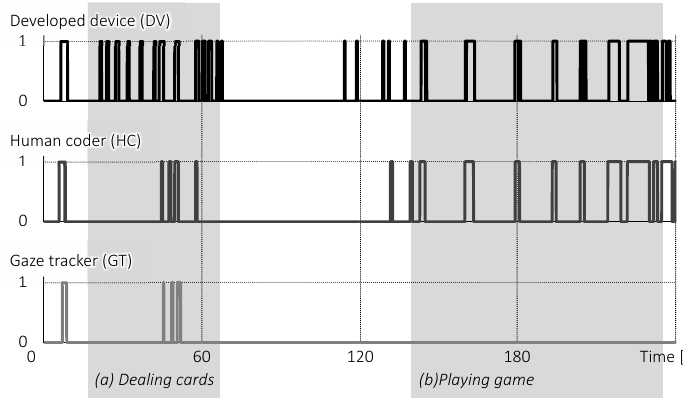
Figure 9. Comparison of the FaceLooks devices (FL1 and FL2) with a human video coder (HC) and wearable gaze trackers (HT): four graphs (x- and y-axes denote standby state (0)/face-to-face state (1) and time, respectively) show the data obtained from the developed device on participants A and B, the human video coder, and the pair of gaze trackers. In Periods (a) and (b), P1 dealt the cards and the others played the